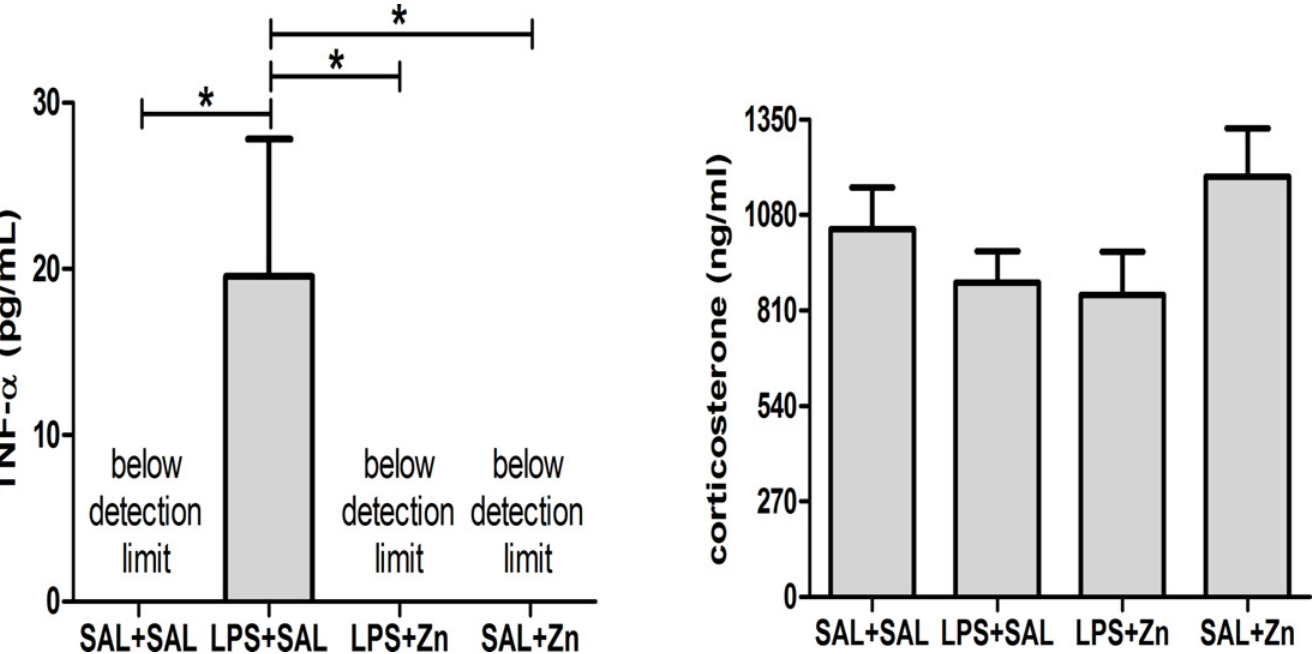
Fig 3. TNF- α and corticosterone. Effects of LPS (100 μ g/kg) and zinc (ZnSO 4 ; 2 mg/kg) on TNF- α and corticosterone plasma levels in adult male rats after a restraint stress challenge. SAL+SAL, saline injection followed by another saline injection 1 h later; LPS+SAL, LPS injection followed by a saline injection 1 h later; LPS+Zn, LPS injection followed by a zinc injection 1 h later; SAL+Zn, saline injection followed by a zinc injection 1 h later ( n = 10 per group). * p < 0.05 (one-way ANOVA followed by the Tukey test). The data are expressed as the mean ±